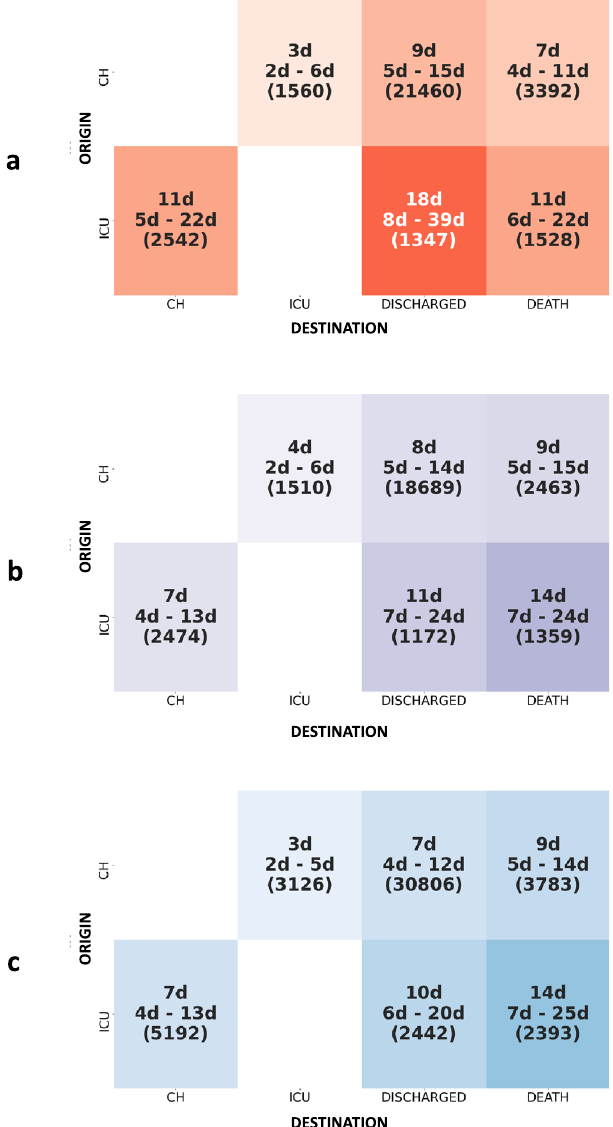
Figure 6. Analysis of lengths of stay by pathway for each of the three periods. Length of stays are expressed in days with their median, 1st and 3rd quartile. Number of patients concerned is given in